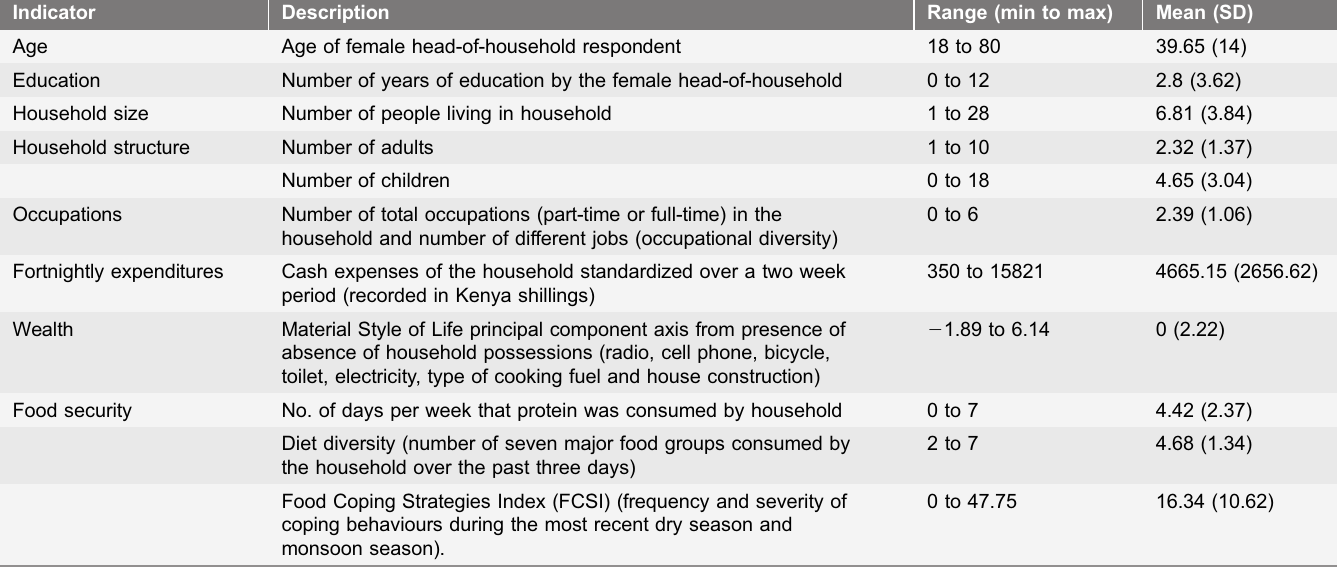
Table 1. Description and summary of social, economic, and food security variables surveyed in four coastal fishing villages in